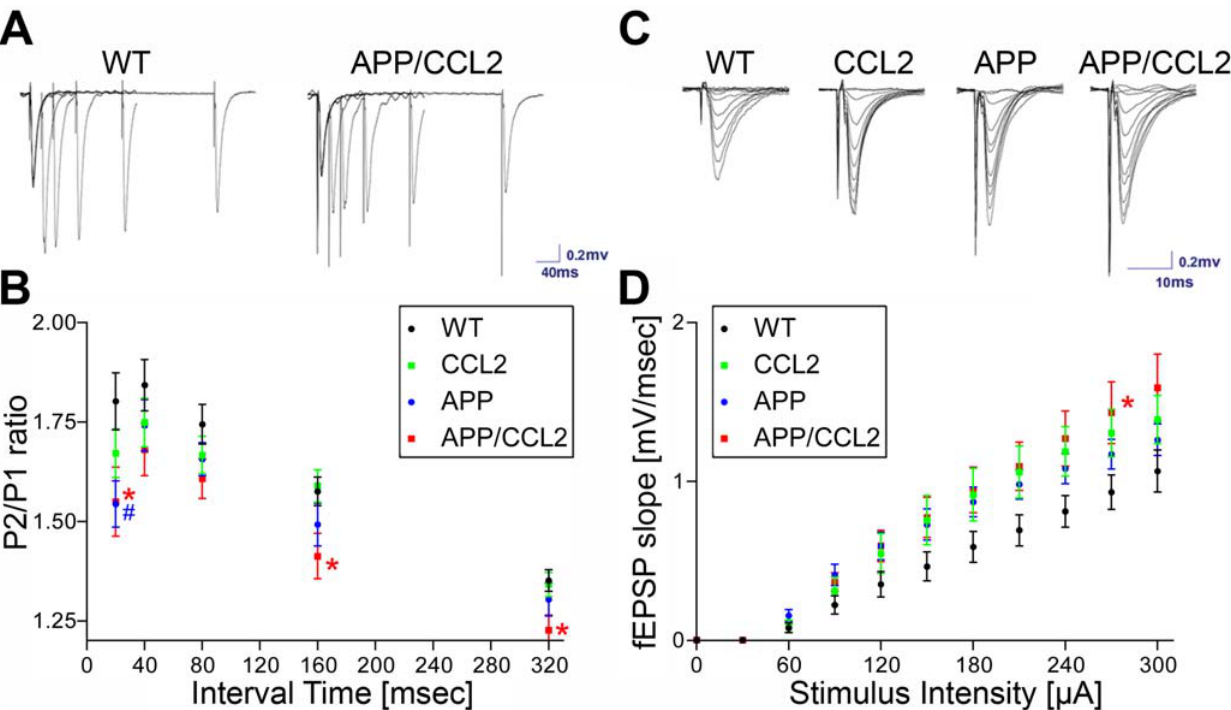
Figure 2. Paired-pulse facilitation and input-output responses recorded in the CA1 region of mouse hippocampal slices. WT (n=15 slices from 8 animals), CCL2 (n=13 slices from 7 animals), APP (n=12 slices from 7 animals) and APP/CCL2 mice (n=14 slices from 7 animals) at 5–6 months of age were tested. (A) Superimposed sample traces of field excitatory postsynaptic potentials (fEPSPs) recorded in the CA dendritic field in response to twin pulse stimulation of Schafer-collateral pathway at various interpulse intervals (as shown in B) in WT and APP/CCL2 mice. (B) Graph plots of averaged paired-pulse facilitation (PPF) ratio at 20-, 40-, 80-, 160-, and 320-msec interpulse intervals in 5–6-month-old WT, CCL2, APP and APP/CCL2 mice. A significant difference between WT and APP/CCL2 mice (*p , 0.05) was found at 20-, 160-, and 320-msec intervals and WT versus APP ( # p , 0.05) at 20-msec intervals as determined by ANOVA and Newman-Keuls post hoc (p , 0.05). (C) Representative traces of superimposed fEPSPs, evoked by single pulse stimulations at various intensities ranging from 30 to 300 m A with an increment of 30 m A, were recorded from slices of WT, CCL2, APP and APP/CCL2 mice, respectively. (D) Averaged input-output curves generated using different stimulus intensities ranging from 0– 300 m A in 30 m A increments as shown in C. Significant difference between WT and APP/CCL2 (*p , 0.05) at the stimulus intensity of 270 m A was determined by ANOVA and Newman-Keuls post hoc .